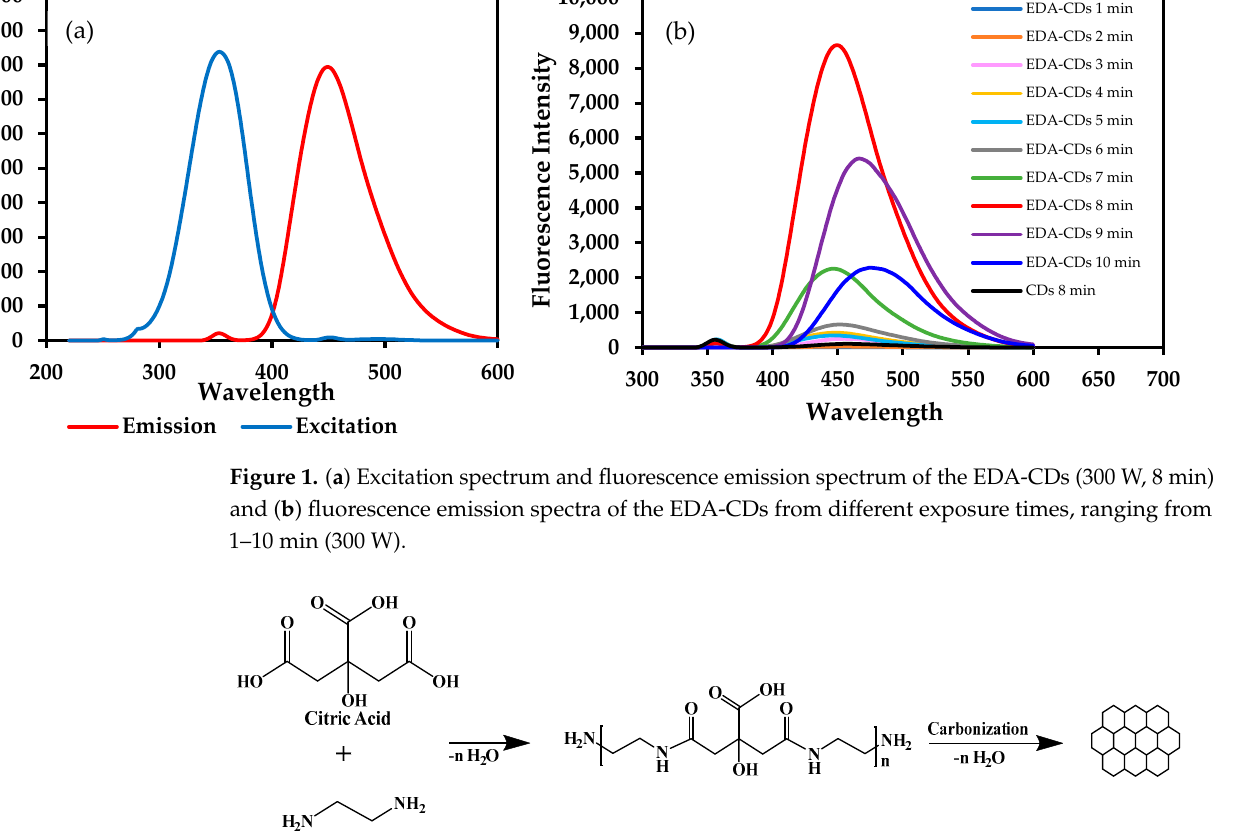
Figure 1. ( a ) Excitation spectrum and fluorescence emission spectrum of the EDA-CDs (300 W, 8 min) and ( b ) fluorescence emission spectra of the EDA-CDs from different exposure times, ranging from 1–10 min (300 W) .